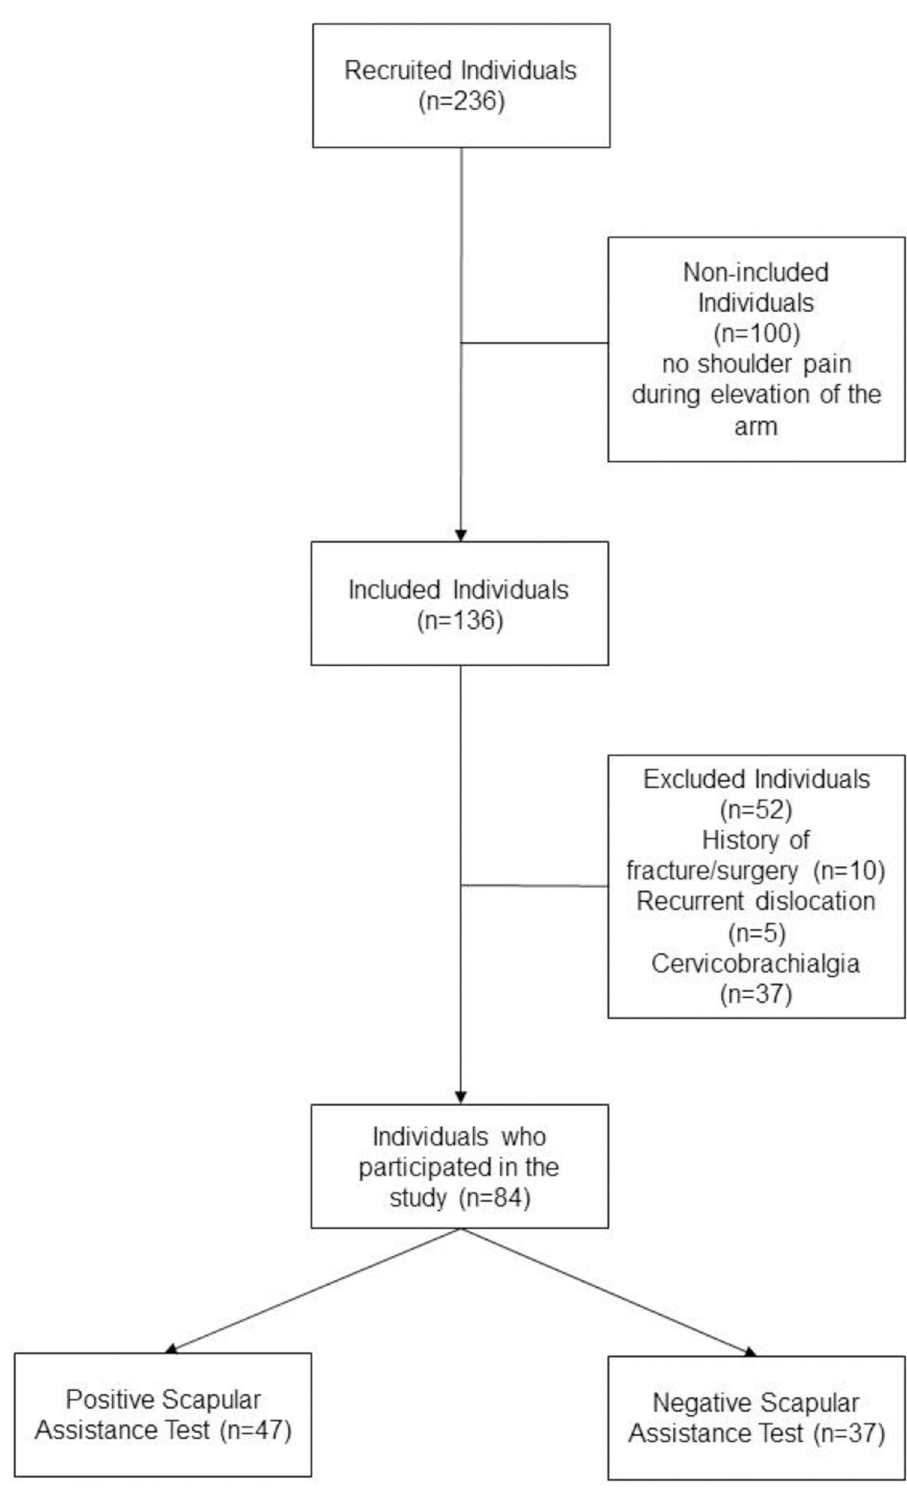
Fig 1. Flow chart of the